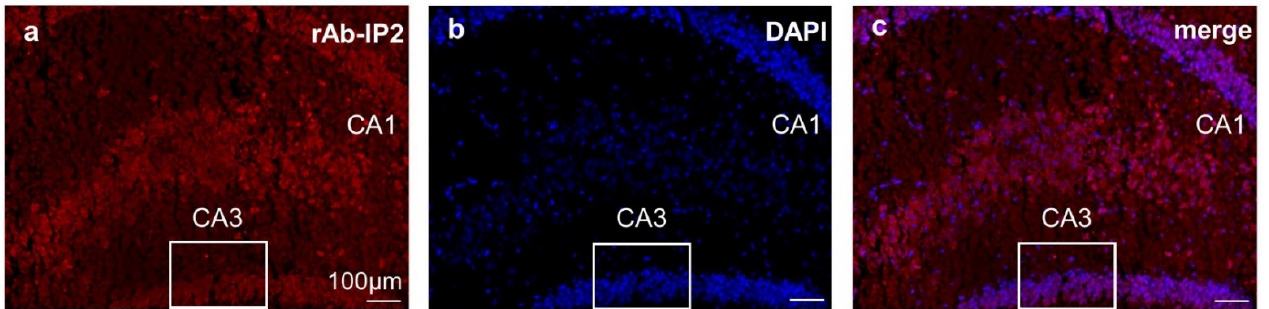
Figure 3. Immunohistochemical staining of a formalin-fixed, paraffin-embedded murine hippocam- pus with the recombinant human GABA A receptor autoantibody rAb-IP2. Murine-fixed hippocampal tissue shows immunoreactivity to the recombinant human antibody rAb-IP2. ( a ) Representative coronal hippocampal slices with immunoreactivity to rAb-IP2 (red). The box marks the hippocampal region CA3, showing the area used for the in vitro electrophysiological recordings as shown in Figures 1 and 2. For more visibility of CA1, we also referred to our previous study [13]. ( b ) DAPI (blue) was used as a marker for the cell nuclei. ( c ) Merged picture. Scale bars represent 100 μ m.